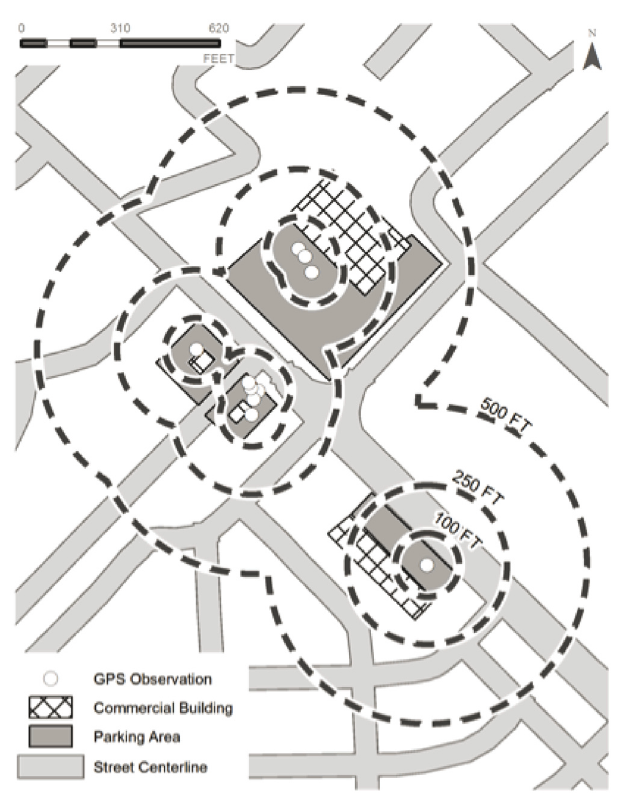
Figure 3. A primary location polygon created using the aggregate points geoprocessing operation with a primary location point placed at its centroid.